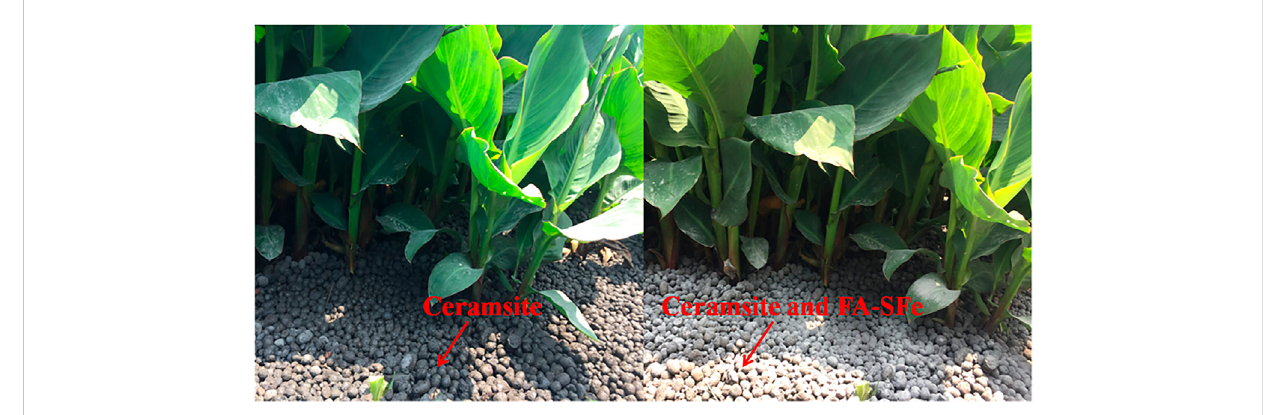
FIGURE 2 CW fi llers with ceramsite and the mixture of ceramsite and